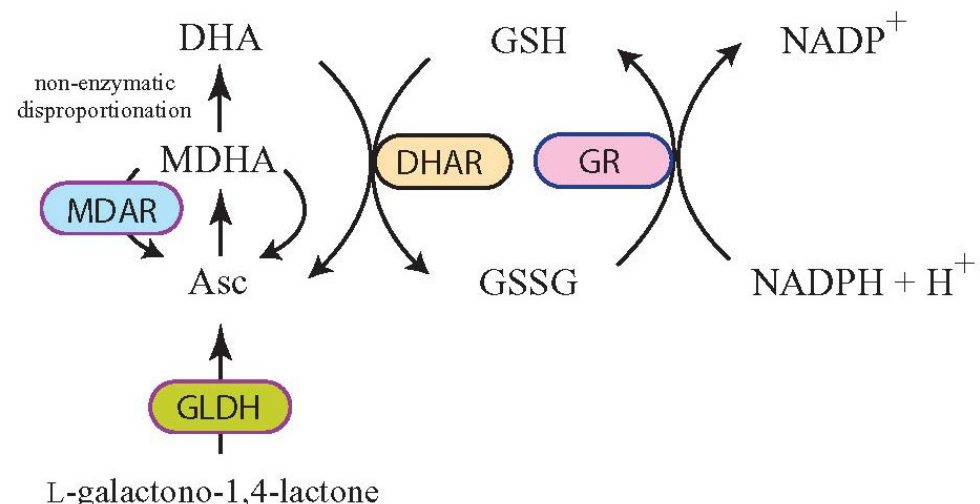
Figure 2. L -Ascorbic acid recycling through DHAR and MDAR. Following Asc synthesis from L -galactono-1,4-lactone by L -galactono-1,4-lactone dehydrogenase (GLDH) and oxidization to monodehydroascorbate (MDHA), monodehydroascorbate reductase (MDAR) can reduce MDHA to Asc. Alternatively, two MDHA molecules can disproportionate non-enzymatically to Asc and dehydroascorbate (DHA). Dehydroascorbate reductase (DHAR) can reduce DHA to Asc using glutathione (GSH) as the reductant. Oxidized glutathione (GSSG) is reduced by glutathione reductase (GR) to GSH using NADPH as the reductant. DHA will spontaneously hydrolyze to 2,3-diketogulonic acid if not reduced by